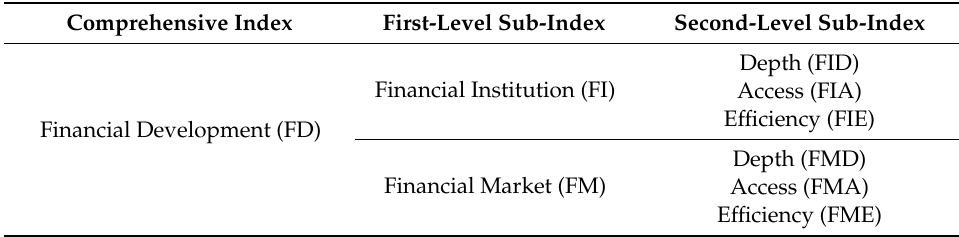
Table 1. Framework of the index proposed by Svirydzenka